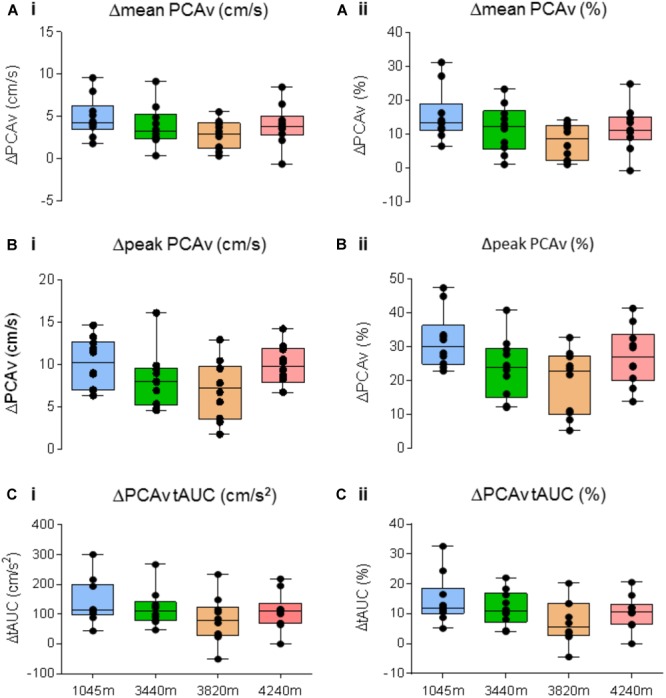
Neurovascular coupling (NVC) response. Comparison of the NVC response for Δmean PCAv, Δpeak PCAv, and ΔPCAv tAUC between altitudes. The magnitude of the response is presented as both the respective Δ from baseline (left column), and the corresponding percentage change from baseline (right column). No significant differences were found for (A)Δmean PCAv (P > 0.05), (B)Δpeak PCAv (P > 0.05), (C)ΔPCAv tAUC (P > 0.05). Presented as scatter plots representing individual participants with box and whiskers showing median, 25–75 percentile with minimum and maximum values.